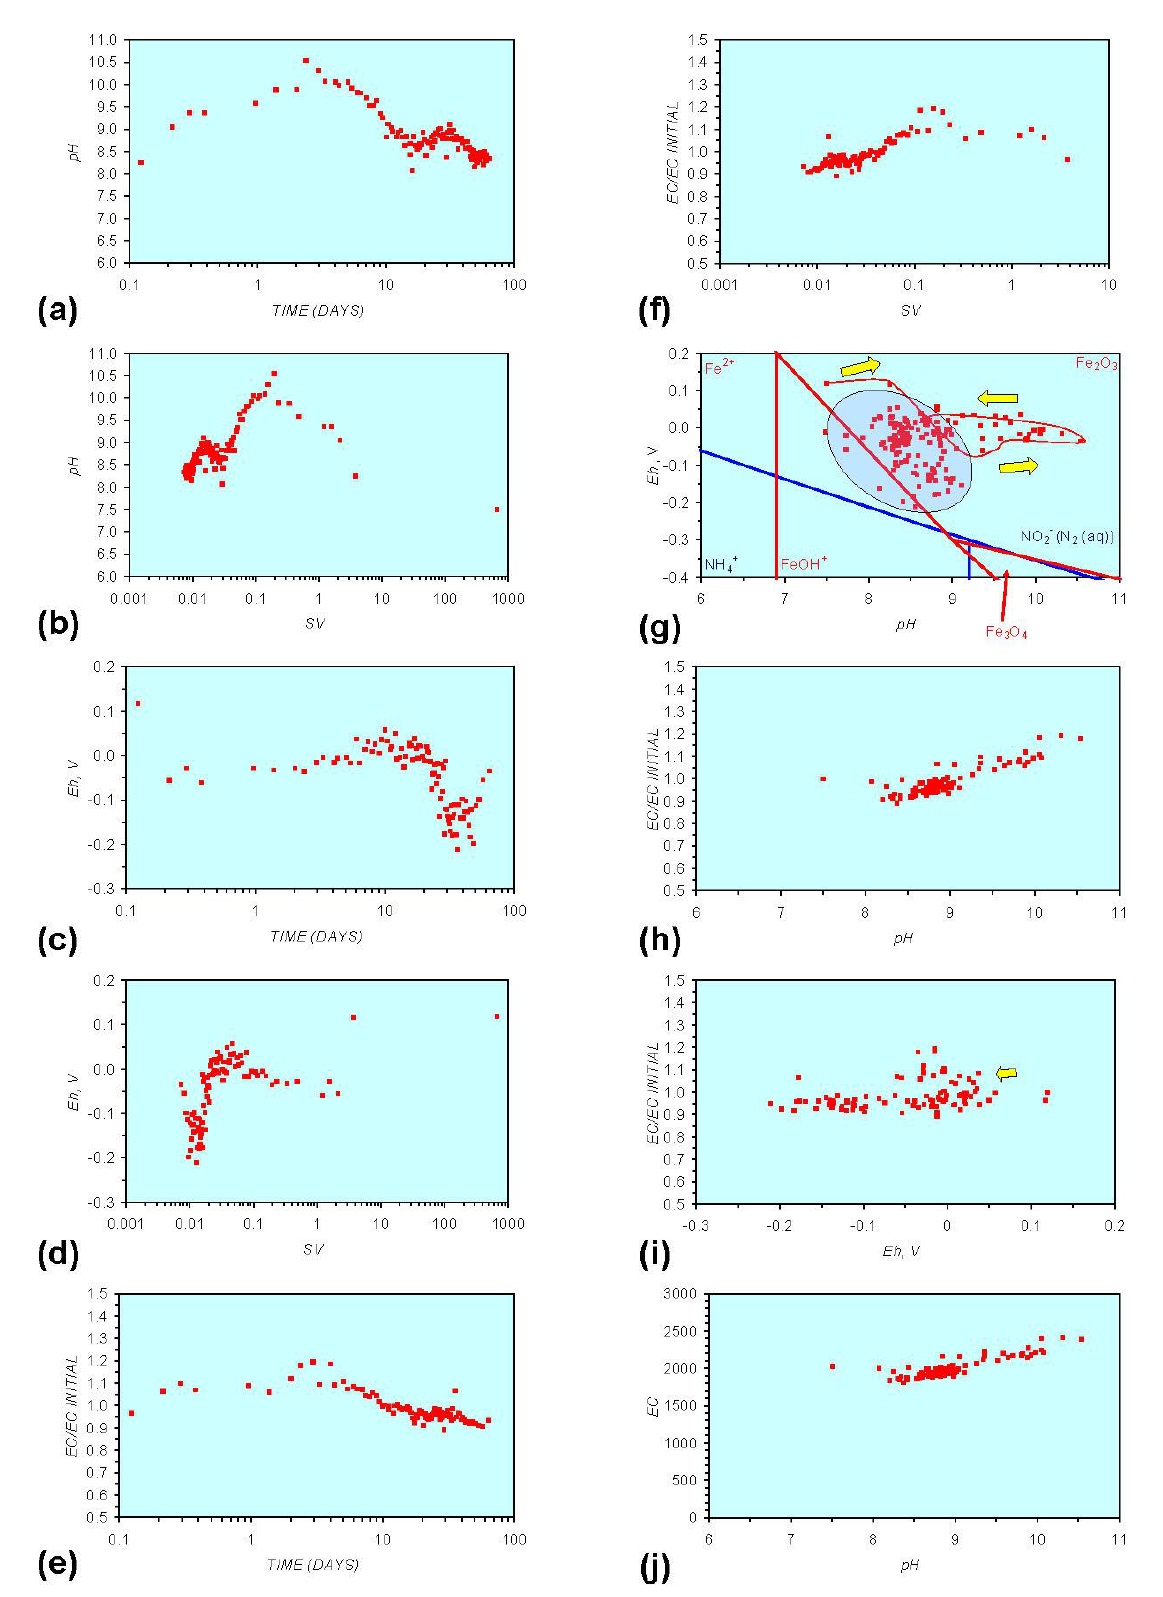
Figure A7. MR7: n-Fe 0 , saline water. (a) pH vs. Time; (b) pH vs. SV; (c) Eh vs. time; (d) Eh vs. SV; (e) EC/EC Initial vs. time; (f) EC/EC Initial vs. SV; (g) Eh vs. pH (SRE ringed); (h) pH vs. EC/EC Initial; (i) Eh vs. EC/EC Initial; (j) pH vs. E(C) Arrows indicate decreasing SV and increasing